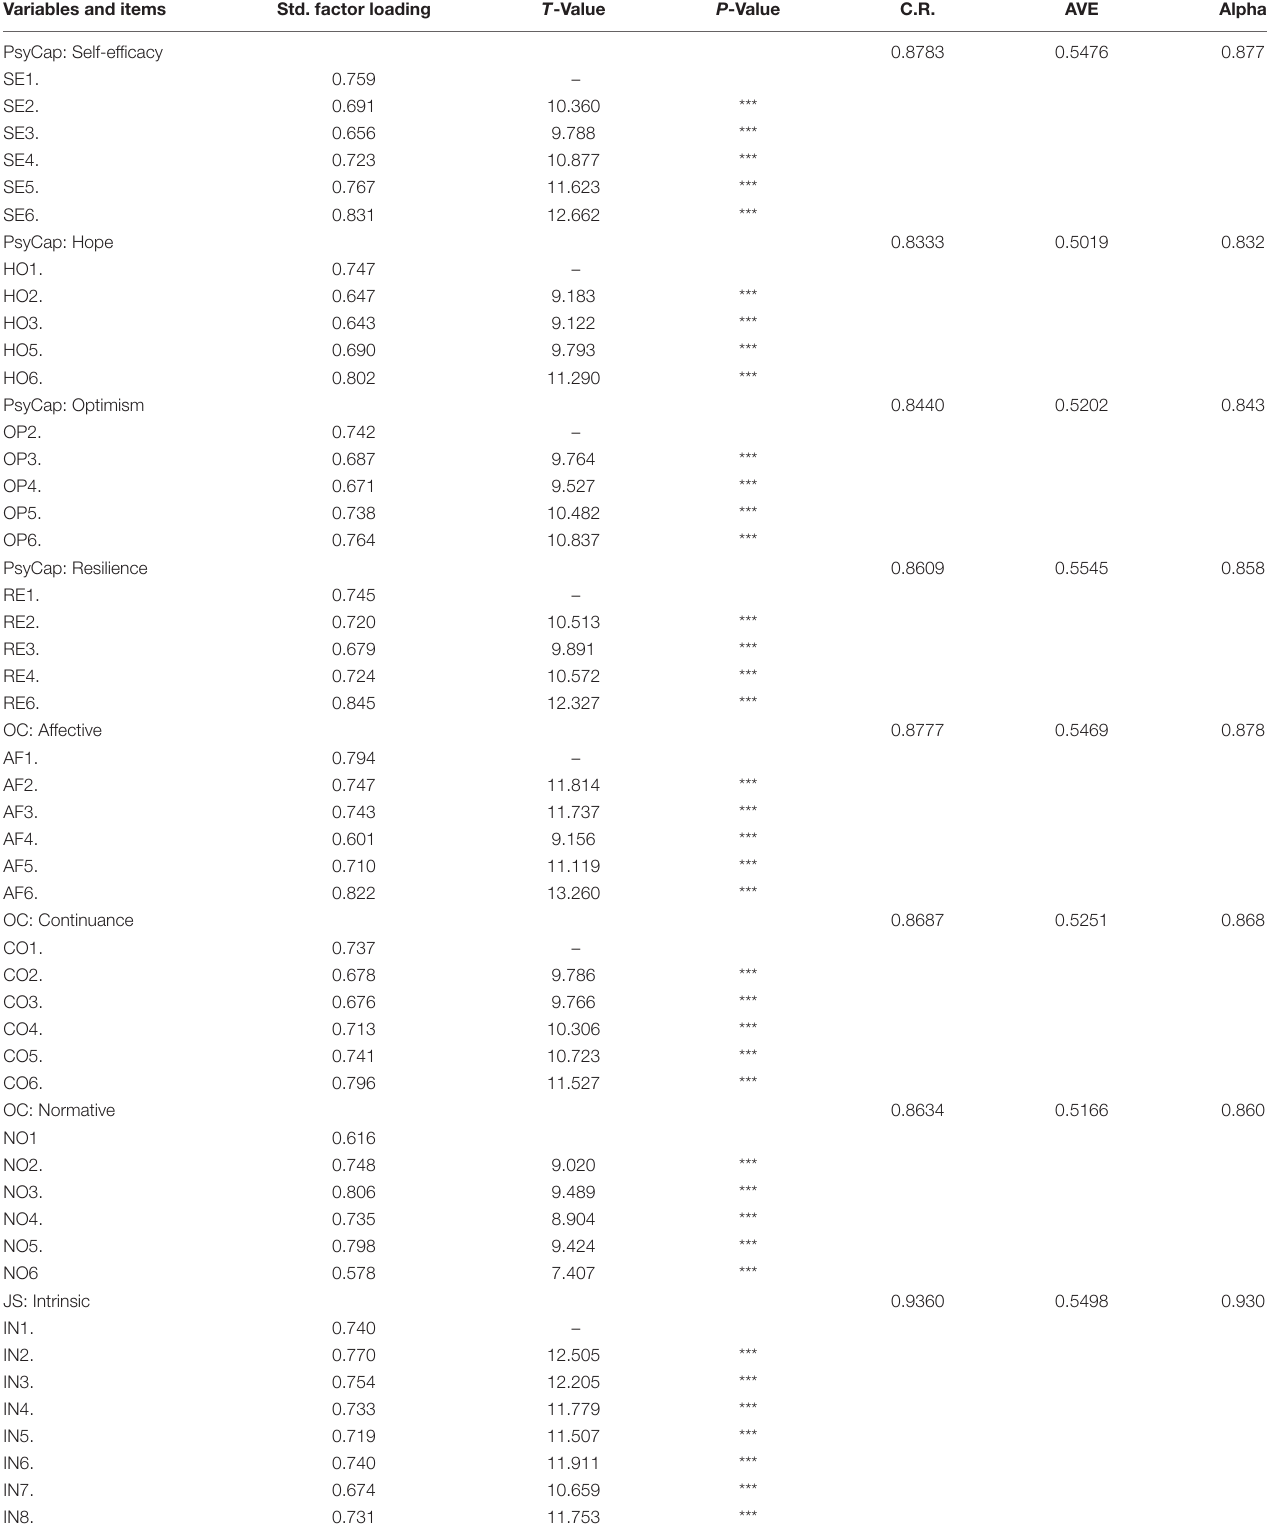
TABLE 2 | Results of reliability and convergent validity of full measurement model. Variables and items Std. factor